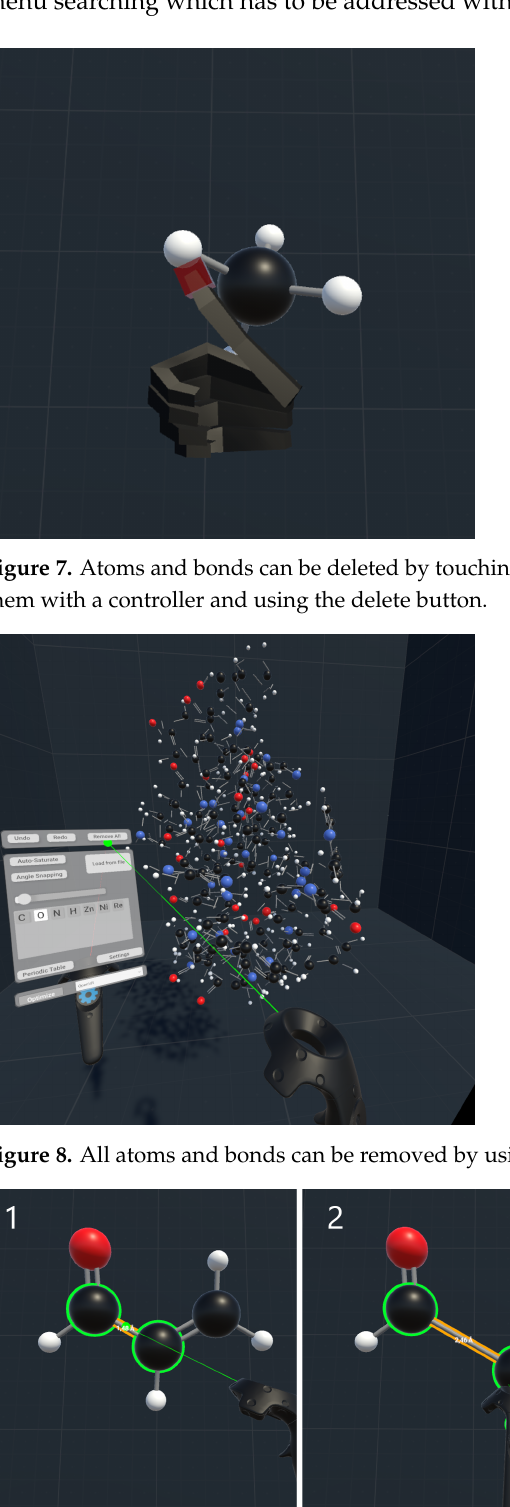
Figure 9. ( 1 ) Activate structure measuring and editing by selecting a bond. Selected objects are highlighted in green and the relevant measure appears. ( 2 ) To edit the highlighted property, such as bond length, grab and one of highlighted atoms. Other properties can be edited by making further selections. The dihedral angle in ( 3 ) can be edited by selecting two adjacent